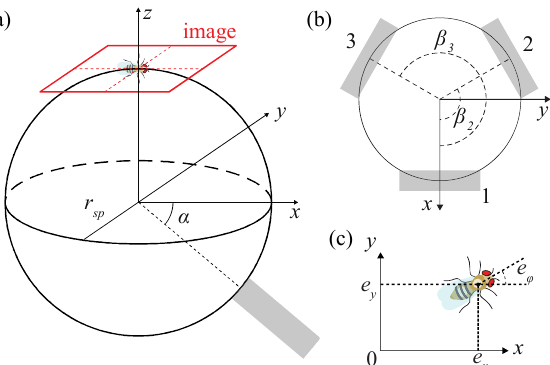
Figure 5. Kinematics of the TOLC system. ( a ) The overall system. The sphere is a transparent acrylic sphere and a gray block is an omnidirectional wheel. Only one wheel among three wheels is shown. The red rectangle is the field of view of a behavior image camera. α is of the omnidirectional wheels respected to the xy -plane. r sp is a radius of a transparent sphere. ( b ) The top view of the system. β is the angle of the omnidirectional wheels 1, 2, and 3 with respect to the x -axis. ( c ) Error of the walking fruit fly on the image e fly ( e x , e y , e φ ), which is the distance from the center of an image. The origin is the center of an image (not shown in here). The coordinate of a NIR image aligns the sphere coordinate.